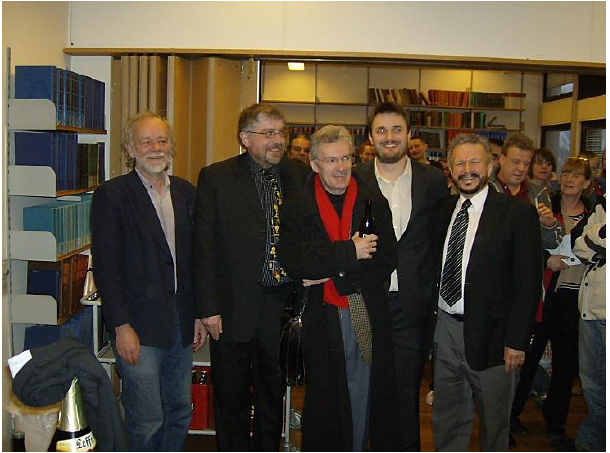
Figure 1. Relaxing after the PhD-defense. From left to right: Klaus Bechgaard (chairman of the committee), the author (supervisor), David Tanner (external member), Michael Pittelkow (the PhD student) and Don.